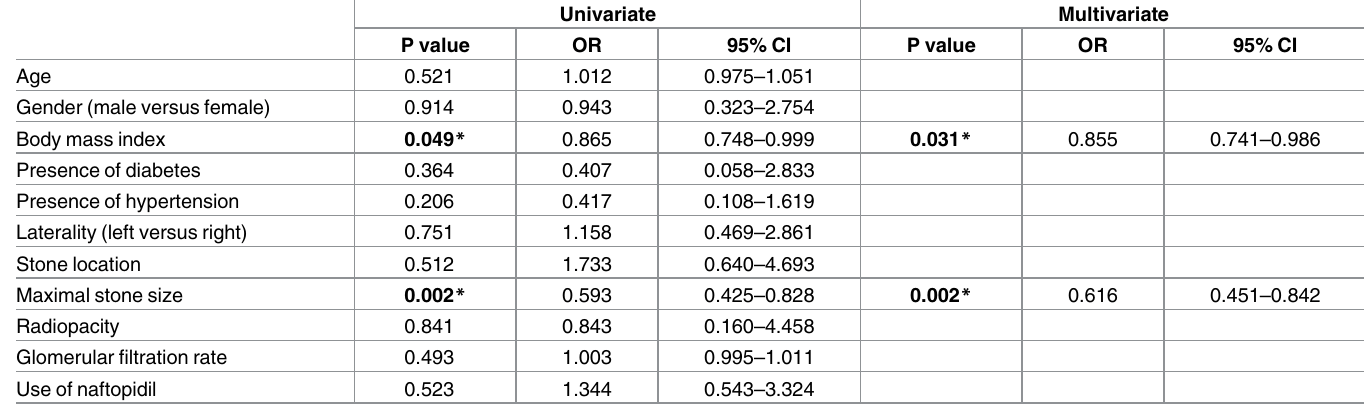
Table 2. Uni- and multivariate logistic regression analysis to predict stone-free status at 14 days after